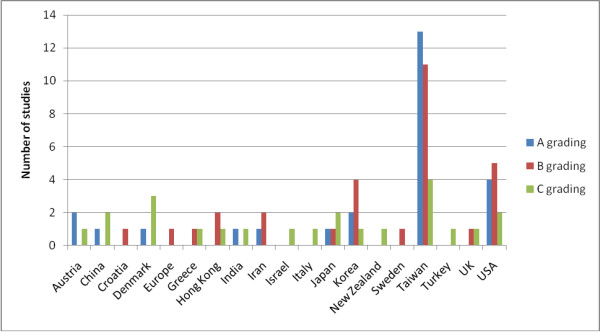
Country of study.